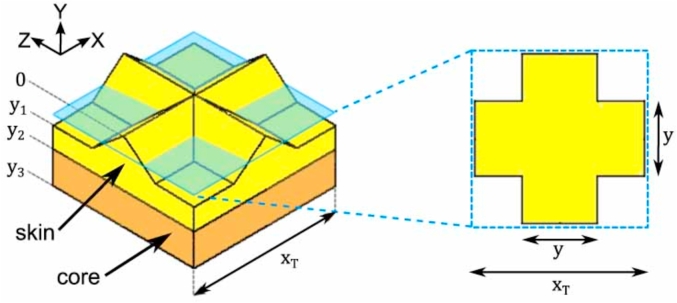
Cross-section of an element of the actual geometry of the baked wafer with measurements required for the analytical model for compression (Pamies et al., 2000).